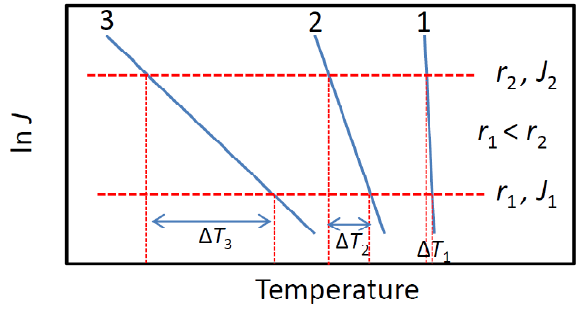
Fig. 8. Illustration of how the slope ln J / T controls the dependence of freezing temperature on cooling rate. In order to maintain the same probability of freezing on increasing the cooling rate (and de- creasing the time for nucleation) it is necessary to go to a lower tem- perature and correspondingly to larger nucleation rate coefficients. If the slope is very steep (line 1) then increasing cooling rate from r 1 to r 2 results in a very small decrease in observed freezing tem- perature ( 1T 1 ) . As the slope decreases in steepness (line 2 and 3) the dependence of 1T on cooling rate increases. In the singular model of ice nucleation dln J /d T → ∞ and nucleation temperature is time